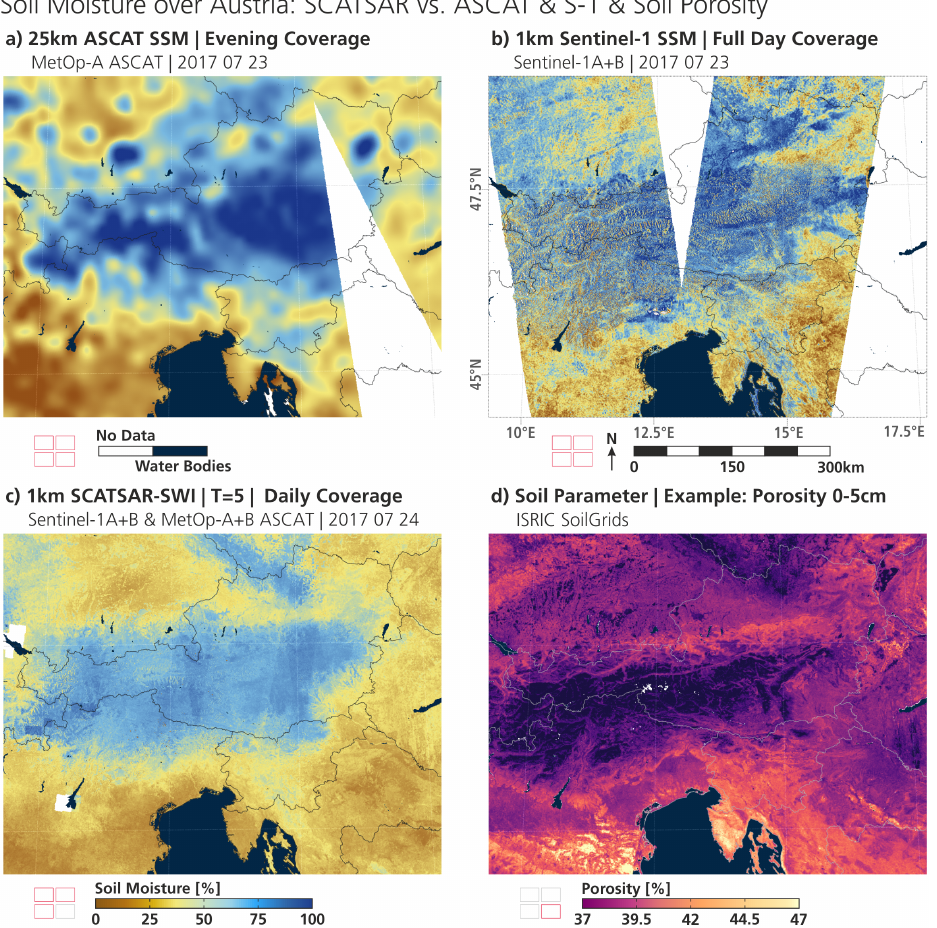
Figure 5. Example images for SCATSAR-SWI and its inputs, and soil porosity for the Austrian area. ( a ) 25 km Metop ASCAT SSM data from two overpasses on the evening of 23 July 2017, where brown colours indicate dry surface conditions, and blue wet conditions. White areas are not covered by the sensors. ( b ) as ( a ), but 1 km SSM from S-1 on the same day; ( c ) the 1 km SCATSAR-SWI at T -value = 5 on the same day; ( d ) for comparison, the porosity of the soil layer down to 5 cm